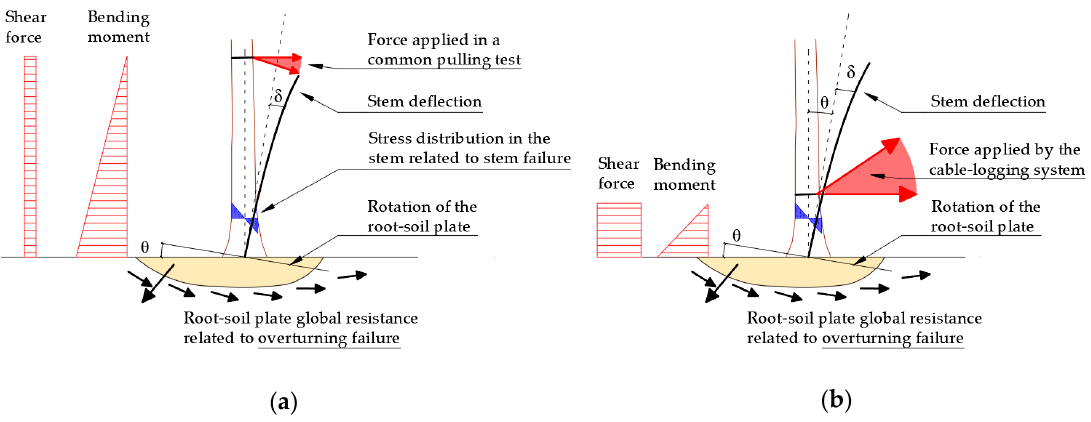
Figure 4. Mechanical model of an anchor subjected to an external applied load: ( a ) common pulling test; ( b ) cable-logging systems.